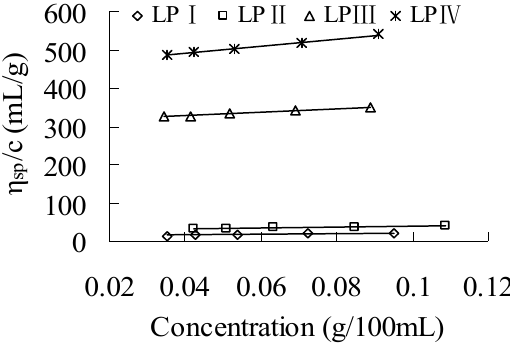
Figure 3. Huggins’ plot of longan polysaccharide fractions LPI–IV in water at 25